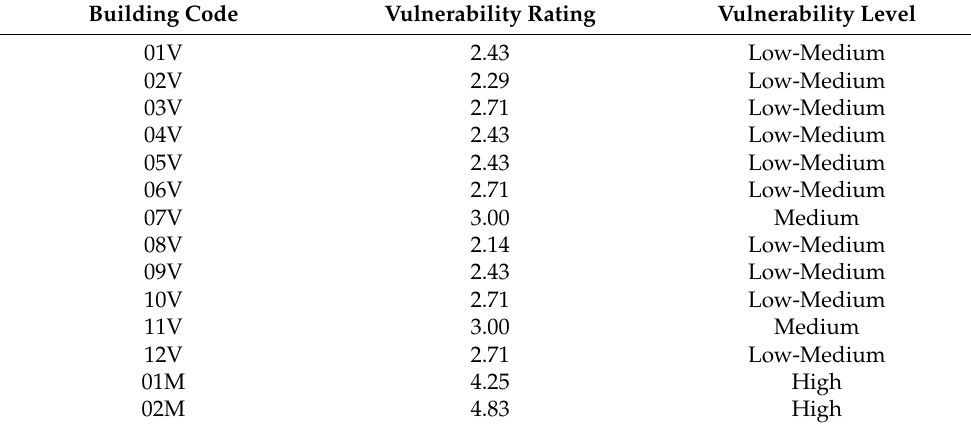
Table 8. Building vulnerability